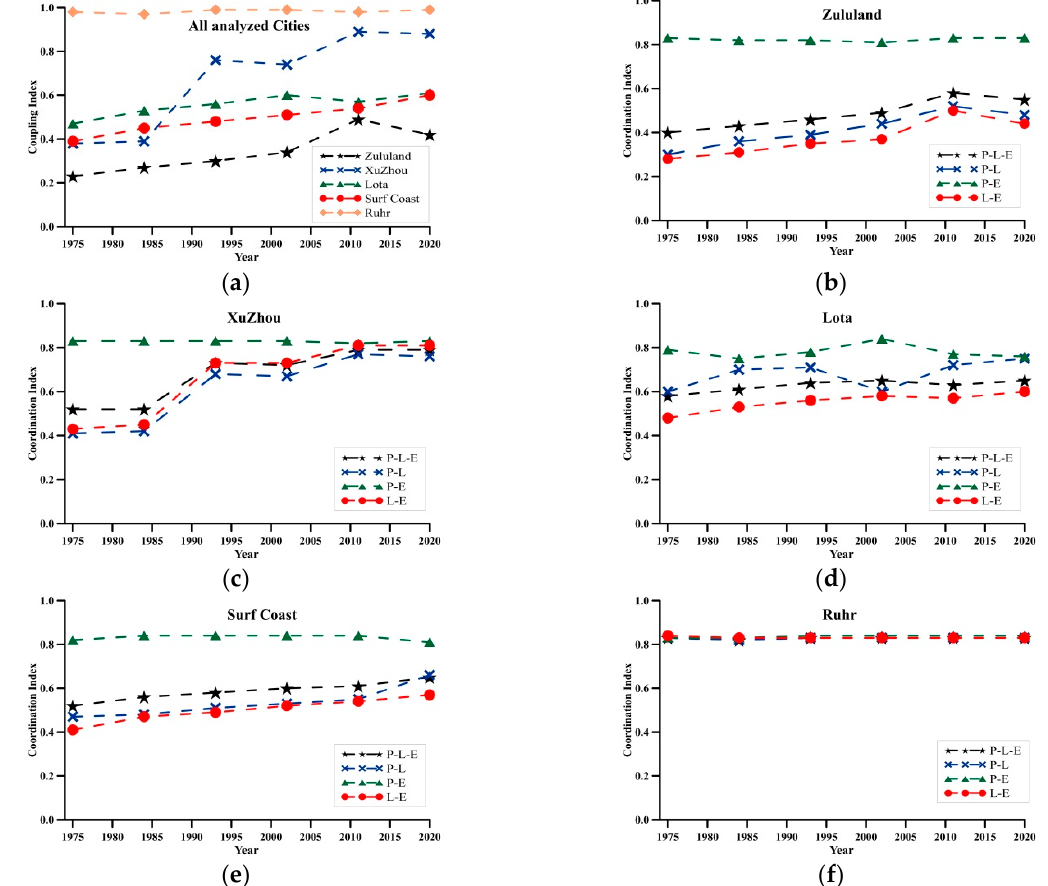
Figure 4. Variation of coupling indexes ( a ) and coordination indexes ( b – f ) of the five cities from 1975 to 2020.